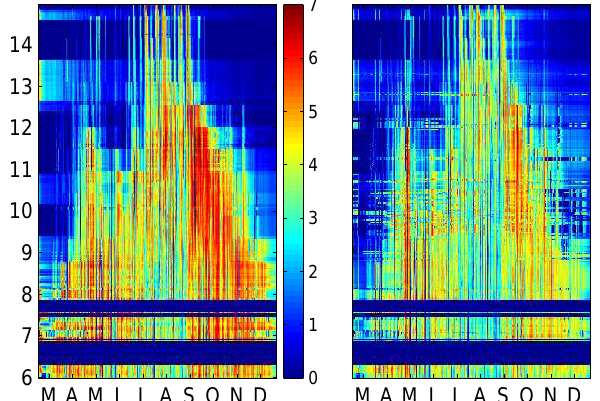
Fig. 11. Simulations along the north–south transect in West Africa from 15 ◦ N to 6 ◦ N: daily ET [mm] simulated using ECOCLIMAP- I (left) and LSA-SAF LAI